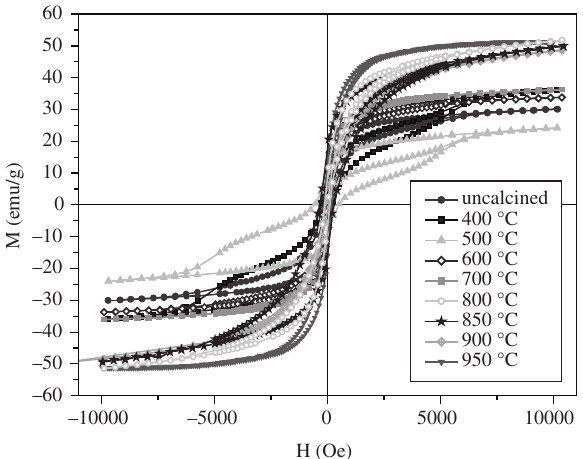
Figure 5. The magnetization curves at room temperature of the samples calcined at 400, 500, 600, 700, 800, 850, 900 and 950